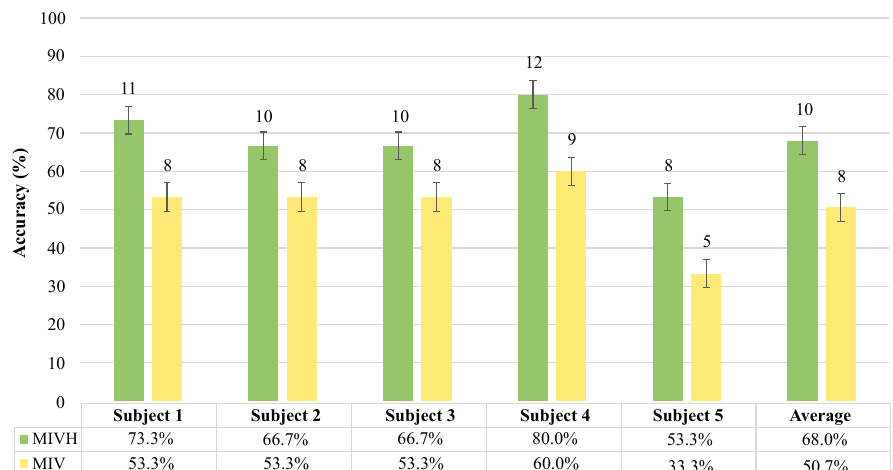
Figure 7. Accuracy results of Motor Imagery (MI) detection for each patient in the Motor Imagery with Visual and Haptic (MIVH) stimuli test in green and the Motor Imagery with Visual (MIV) stimulus test in yellow. Each bar graph presents in its upper side the number of MI attempts achieved over the 15 opportunities presented throughout each of the two stages. The last two bars to the right side are the average of the five subjects’ accuracy.